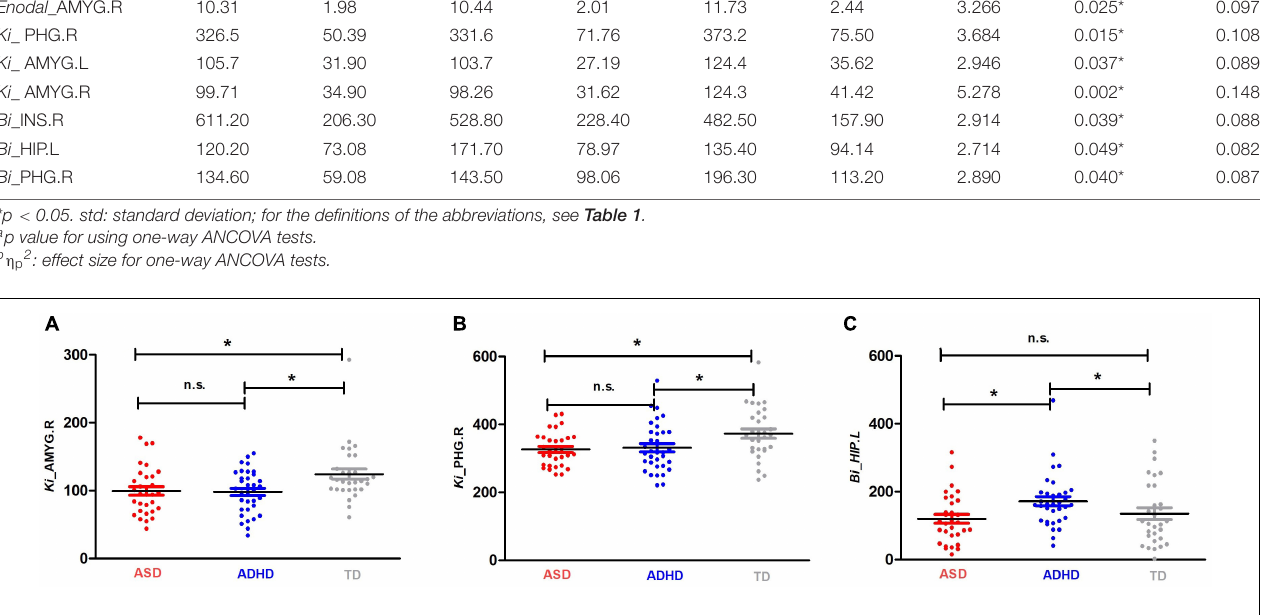
FIGURE 1 | Shared and specific nodal topological properties in diagnostic groups. (A,B) represent the regions with shared deficits in ASD and ADHD topological properties compared with the properties of TD controls, and (C) represents the region in which ADHD topological properties differ from both TD controls and individuals with ASD by Bonferroni post hoc analysis; for the definitions of the abbreviations, see Table 1 . For each node, the bar and error bar represent the mean value and SD, respectively; a single asterisk (*) represents a significant group difference at p < 0.05; n.s. represents no